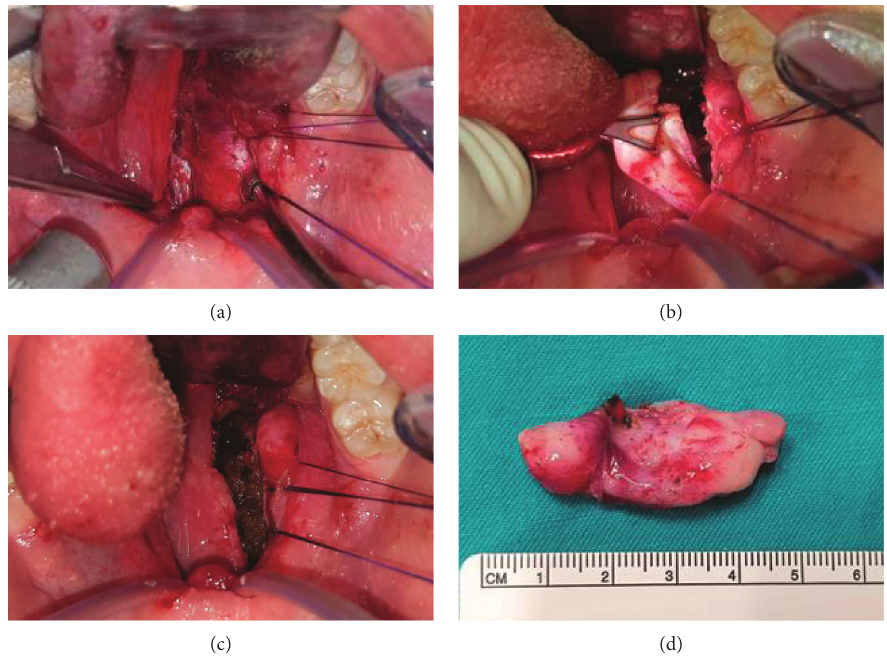
Figure 2: Intraoperative transoral excision views. (a) Vertical lateral pharyngeal wall incision exposing submucosal cyst. Soft palate catheter-retracted and ipsilateral tonsil suture-retracted to improve exposure. (b) Cyst wall grasped following planned evacuation of contents to facilitate lateral and superior blunt dissection off major neck neurovascular structures. (c) Resultant cavity filled with Fibrillar ™ Surgicel ® layers before pharyngeal incision is closed. (d) BCC surgical specimen after complete excision.